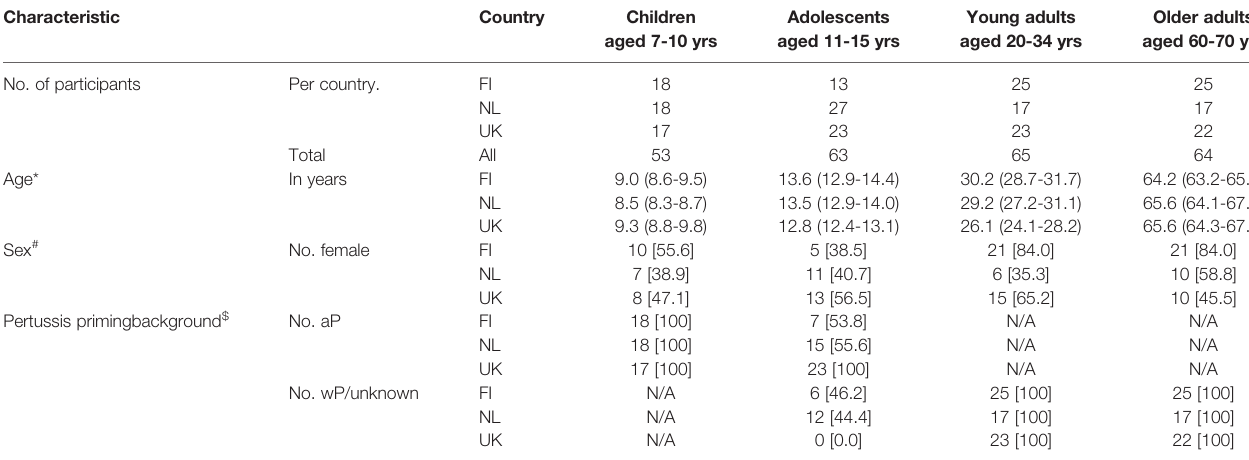
TABLE 1 | Participant characteristics.